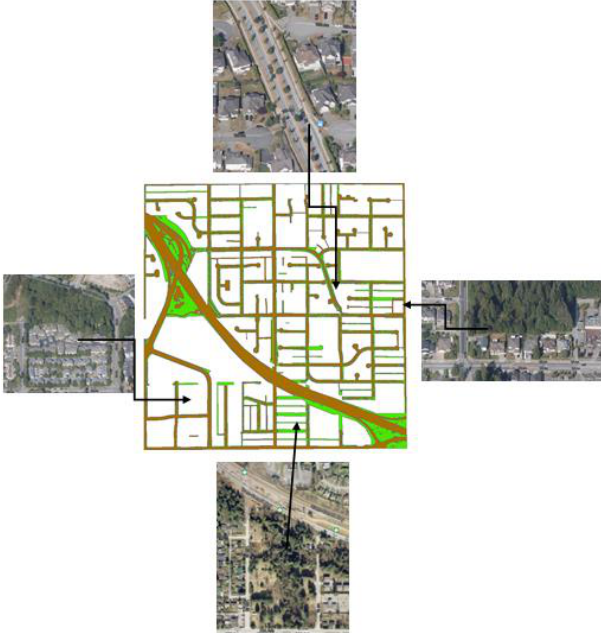
Figure 7.Refined classification of the road allowance area